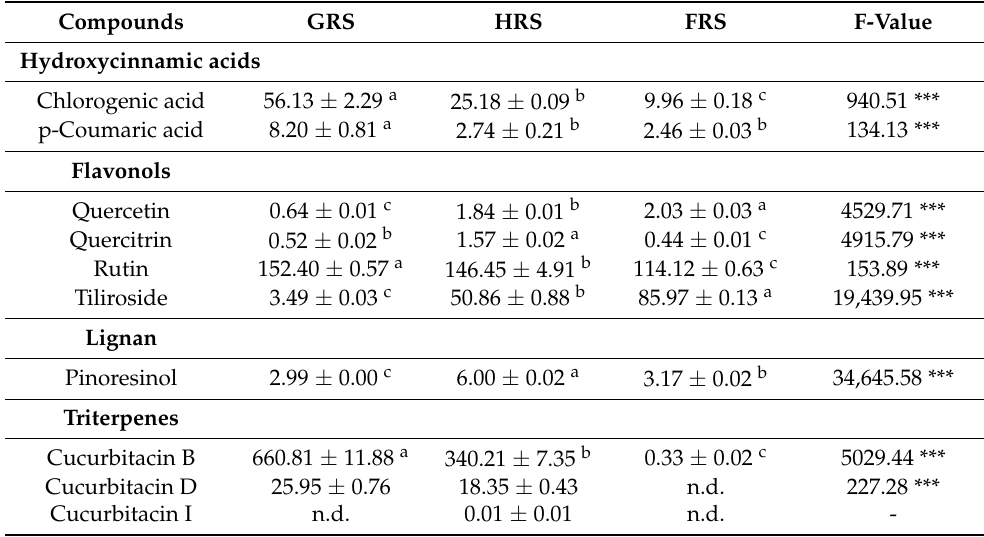
Table 2. Changes in the phytochemical compositions (mg/kg) of Coccinia grandis fruits to the dry matter at different stages of